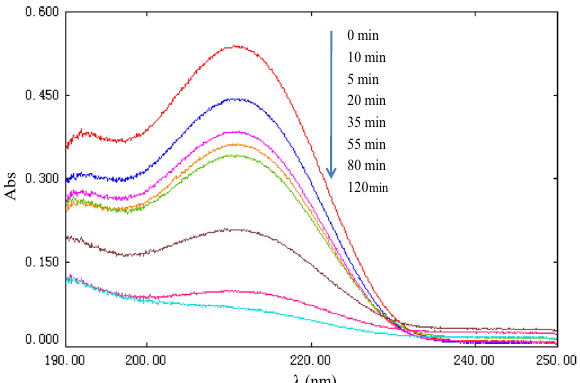
Figure 7. UV spectra for degradation reaction mixtures of [C 4 mim][BF 4 ] at various reaction times in US-assisted ZVZ/AC system: